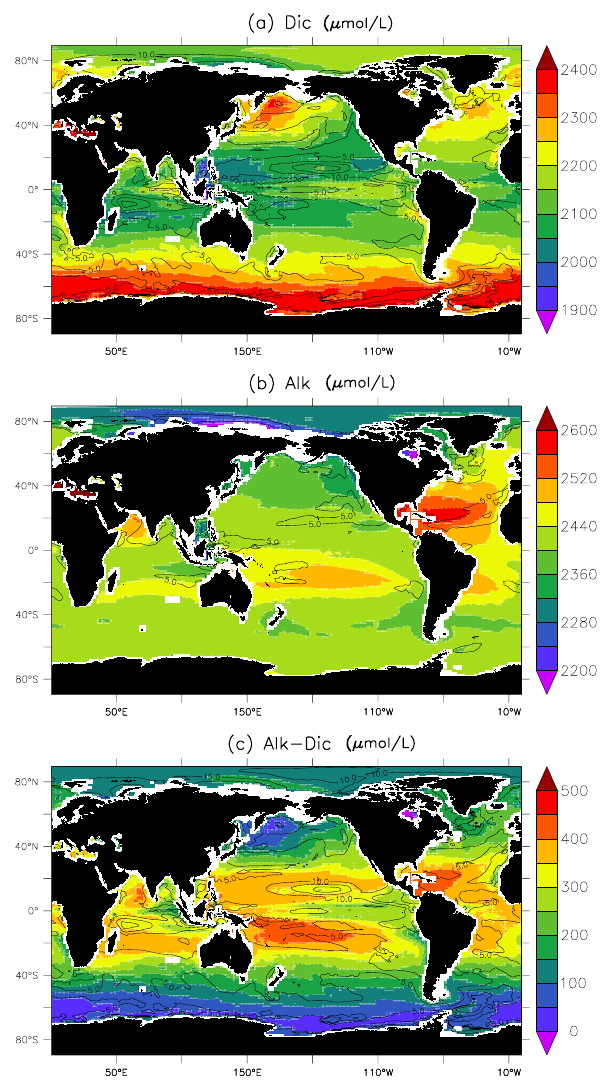
Fig. 9. Long-term mean of (a) DIC, (b) Alk and (c) Alk-DIC con- centrations (in µmolL − 1 ) at maximum (winter) mixed-layer depth. Variability represented by the standard deviation of the concentra- tions of (a) DIC, (b) Alk and (c) Alk-DIC is